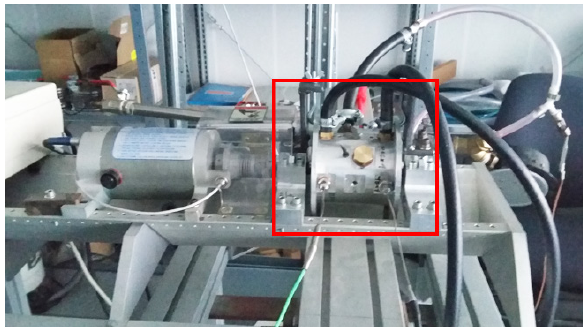
Figure 8. Measurement experimental device with red rectangle device case